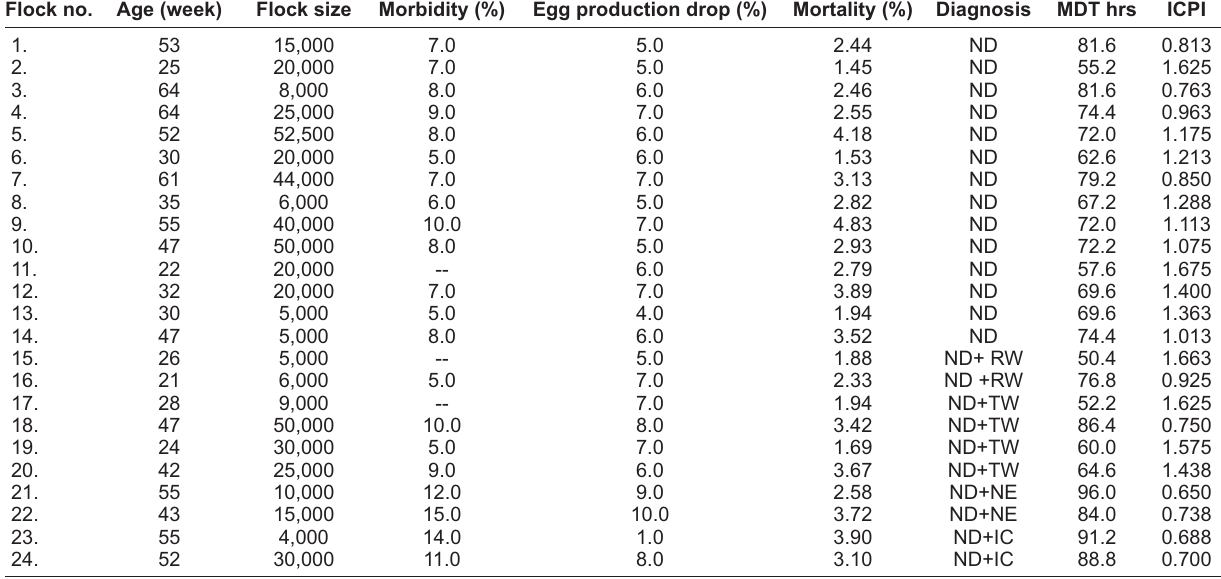
Table-1: Clinical history and biological characteristics of NDV isolated from flocks with gastrointestinal tract lesions. Flock no. Age (week)